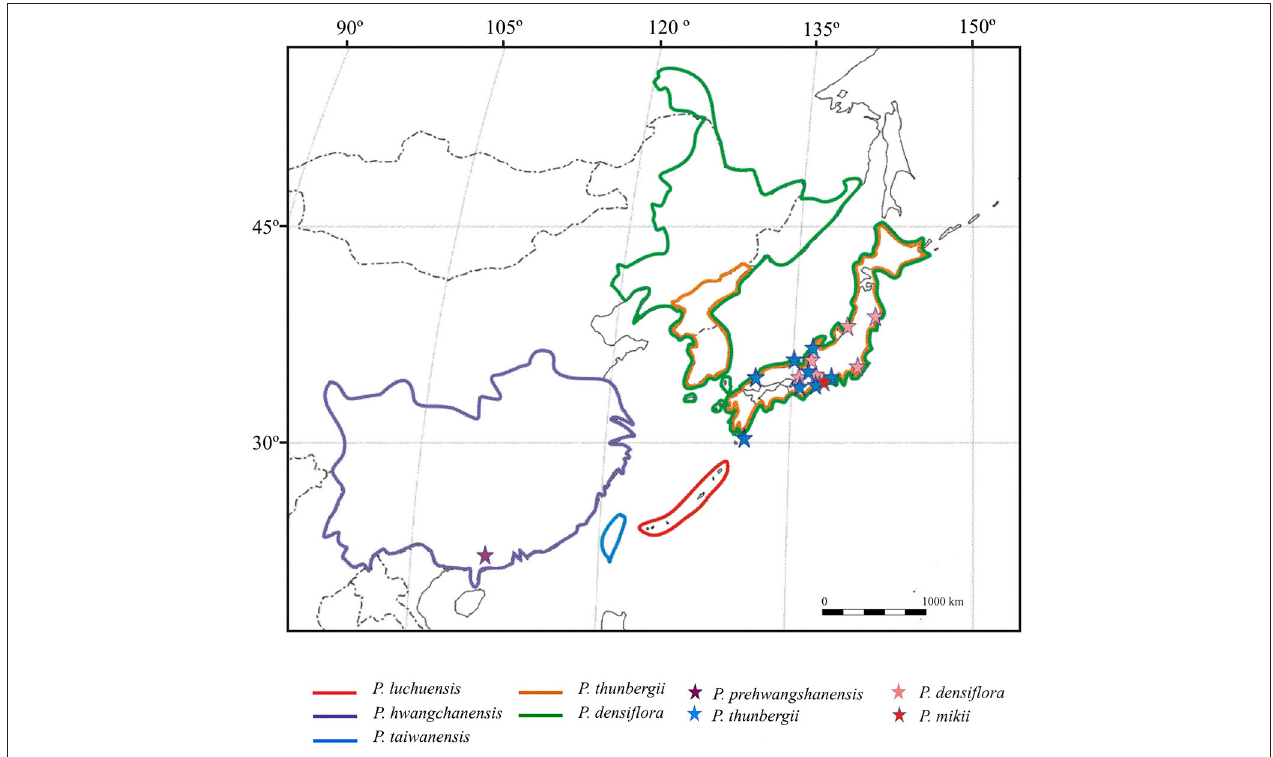
FIGURE 12 | Distribution of the extant species closely related to the new fossil-species Pinus prehwangshanensis (after Forest et al., 2018; species areas are bounded by color lines), and occurrences of related fossil-species (after Miki, 1957; Yamada et al., 2015; occurrences are marked by asterisks).